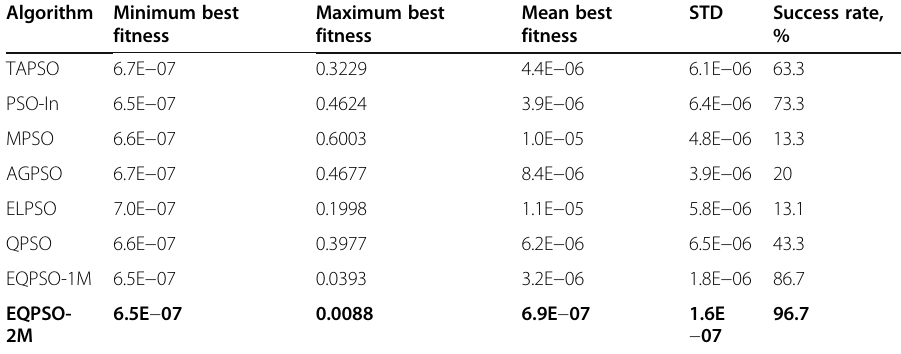
Table 5 Comparison results between EQPSO-2M and other algorithms Algorithm Minimum best